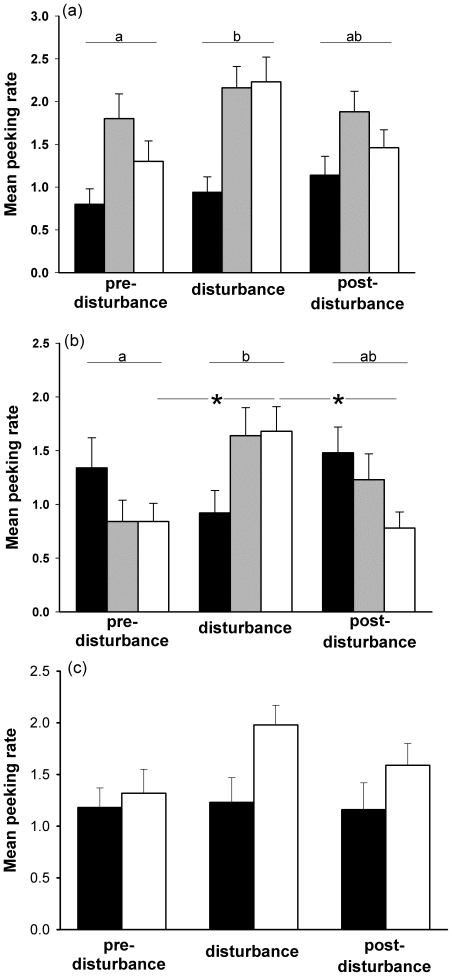
Peeking rate in mallards (a), in teals (b) and in tufted ducks (c) for the control group (black bar), group 1 (grey bar) and group 2 (white bar) for each observation week.Letters indicate significant differences between weeks. *Indicates significant differences between weeks for a group or between two groups.